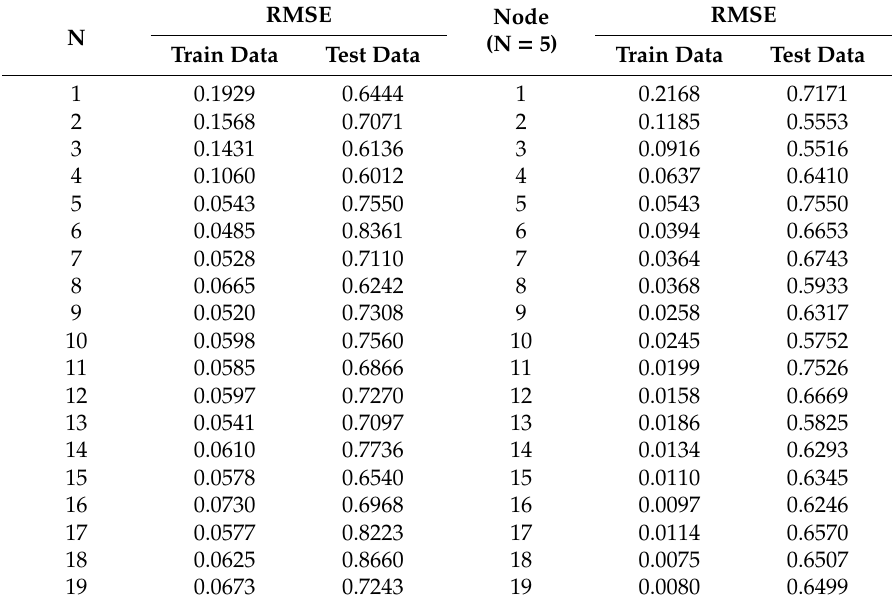
Figure 19. RMSE graph according to N value.